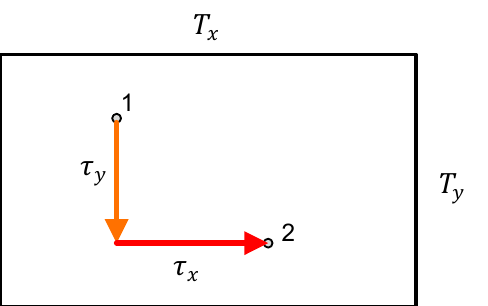
8 of 14 Figure 7. Graphs of the probability density functions of travel times for trips and cycles in a one- dimensional zone with T = 42 s: Cyan dashed 𝒇(𝝉 𝑲 ) for a semi-random trip from/to the storage/retrieval (S/R) station; magenta dashed 𝒇(𝝉) for a random trip between two random locations; black dotted 𝒇(𝝉 𝑴𝑨𝑿 ) for the maximal value of two semi-random trips; green solid 𝒇(𝝉 𝑺𝑪 ) for a single command (SC) cycle; blue solid 𝒇(𝝉 𝑫𝑪 ) for a dual command (DC) cycle. 4. Two-Dimensional Zone with Taxicab Geometry We consider a rectangular service zone with size 𝐿 (cid:3400) 𝐻 , in which service requests may appear uniformly distributed anywhere within the zone. Let us assume that the zone is served by a mobile server travelling only in directions parallel to the rectangle sides—it can travel in a direction either parallel to the long side or parallel to the short side. It cannot travel simultaneously in both directions. Such a model may represent the travelling of a forklift within a warehouse or a cab through a city with orthogonal streets. The distance measurement in this setup is known as the Manhattan metric, and it equals the sum of the distance travelled in each direction. Let the server travel with velocity 𝑣 (cid:3051) along the side with length L and with velocity 𝑣 (cid:3052) along the side with length H . Then the maximal times for travelling in the corresponding directions are 𝑇 (cid:3051) = 𝐿/𝑣 (cid:3051) (direction X) and 𝑇 (cid:3052) = 𝐻/𝑣 (cid:3052) (direction Y). The maximal total travel time for a single trip within the zone is then 𝑇 = 𝑇 (cid:3051) + 𝑇 (cid:3052) . The model setup in the time domain is presented in Figure 8,